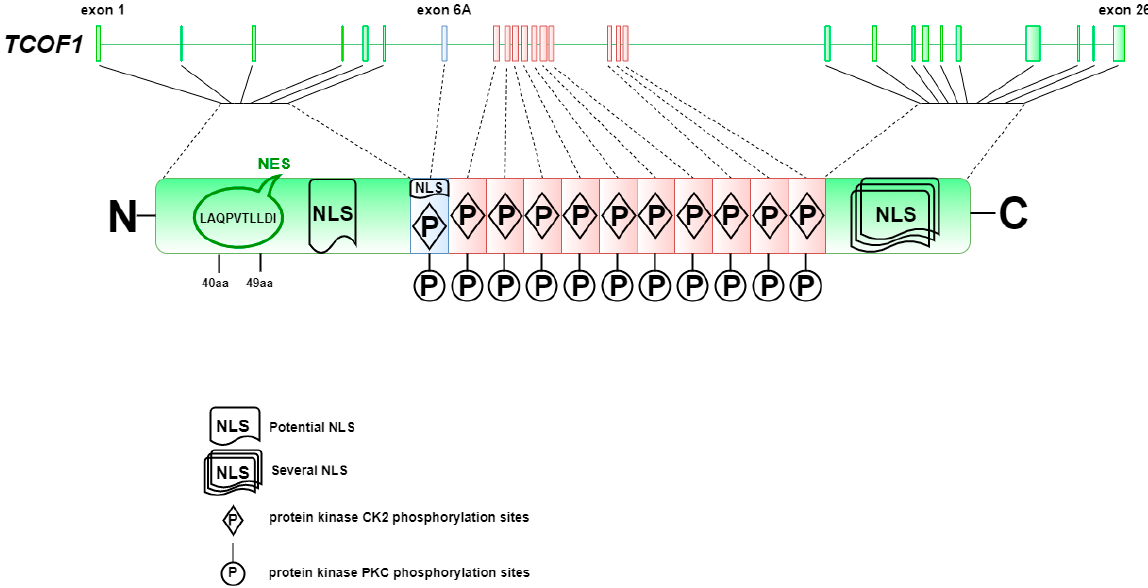
Figure 1. The structure of the major treacle isoform including amino acids encoded by exon 6A. The exon location was retrieved from Ensembl (https://www.ensembl.org), transcript ID: ENST00000377797.7, accessed on 11 May 2020. The N-terminus is encoded by six exons and contains nuclear export signal (NES) and potential nuclear localization signal (NLS) regions. The central domain encoded by exons 6A-16 consist of 11 repetitive motifs that are phosphorylated by CK2 and protein kinase C (PKC). The motif encoded by exon 6A has an additional NLS region. The C -terminus is encoded by exons 17–26 and contains several NLS regions in exons 23, 24 and 25 [12] .